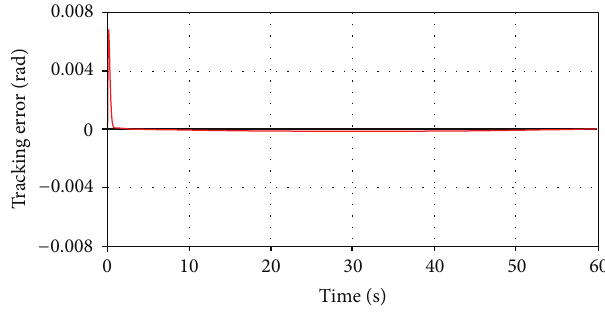
Figure 9: The tracking error during